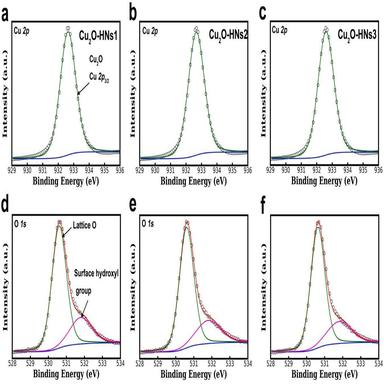
X-ray photoelectron spectroscopy of Cu 2p and O 1 s for (a, d) Cu2O-HNs1, (b, e) Cu2O-HNs2, and (c, f) Cu2O-HNs3, respectively.